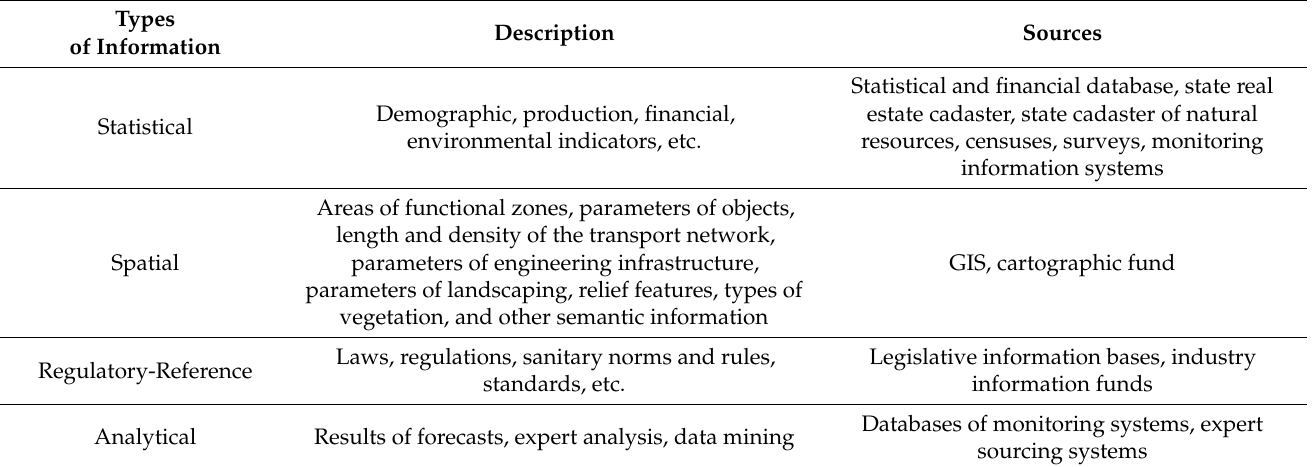
Table 1. Types and sources of information.